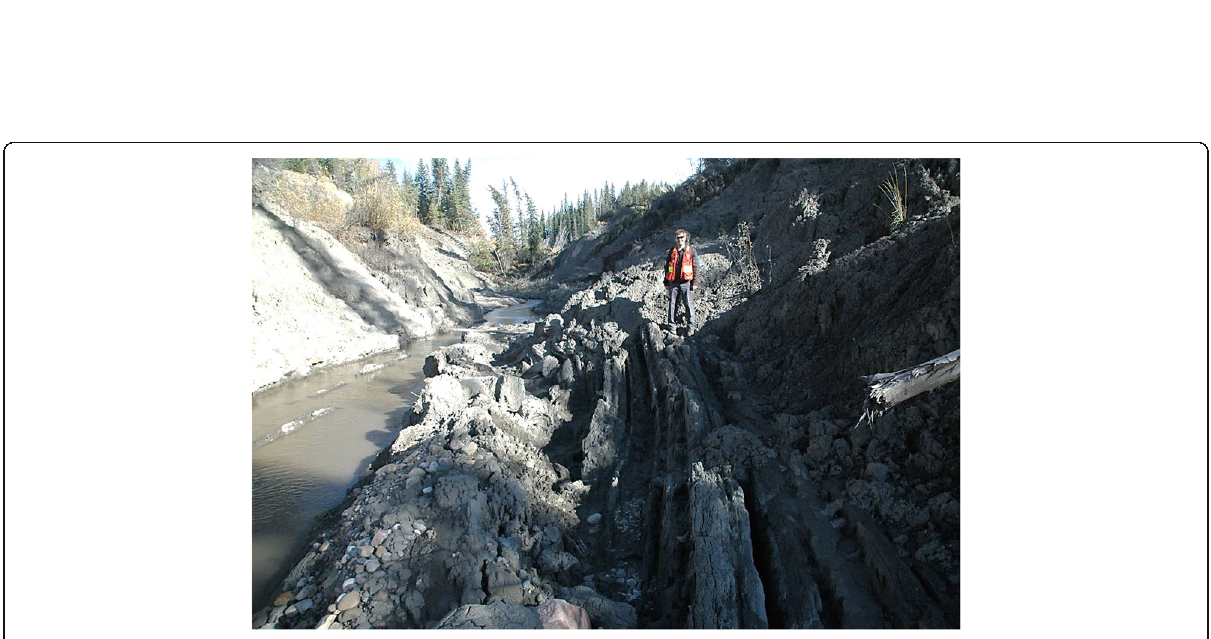
Fig. 3 Upthrust advance phase glacial lacustrine sediment (LTA3) at the toe of the Eureka River landslide. The reorientation of the lacustrine rhythmites to near vertical, was likely caused by the landslide. Note the scattering of boulders and cobbles at discrete locations. This material likely originated in the pre-landslide channel and was introduced into the post-landslide channel by bank erosion. Also note the small landslide into the channel in the distance. (Source: BGN Miller, September 28, 2007)